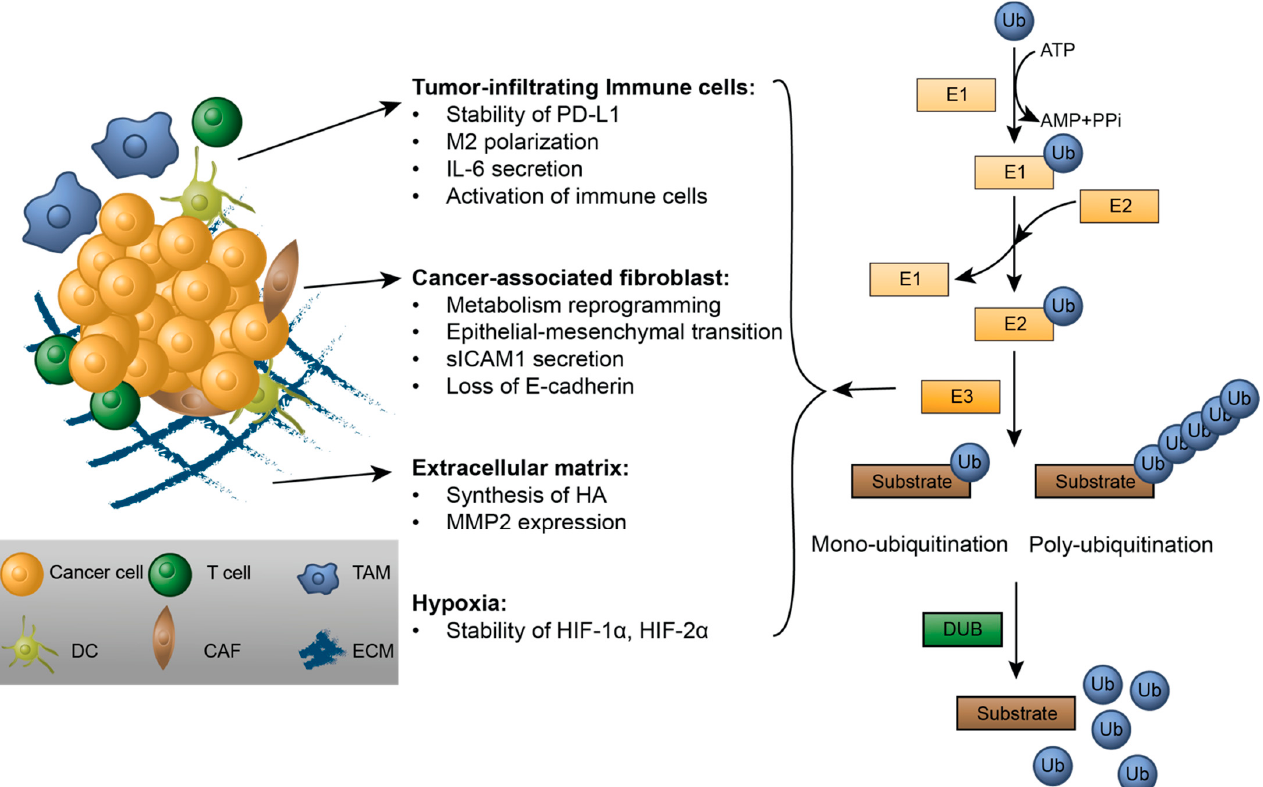
Figure 1. The role of ubiquitin signaling in the tumor microenvironment (TME). Shown on the left, the TME is composed of both cellular and non-cellular components, including tumor-infiltrating immune cells, cancer-associated fibroblasts (CAF) and the extracellular matrix (ECM) and exhibits hypoxia as well. The ubiquitin signaling pathway is shown on the right. Ubiquitin can be attached to substrates by mono-ubiquitination or poly-ubiquitination in the E1-E2-E3 enzymatic cascade and removed from substrates by deubiquitinases (DUB). Multiple E3s and DUBs are implicated in the regulation of multiple TME components, as described in detail in the text.